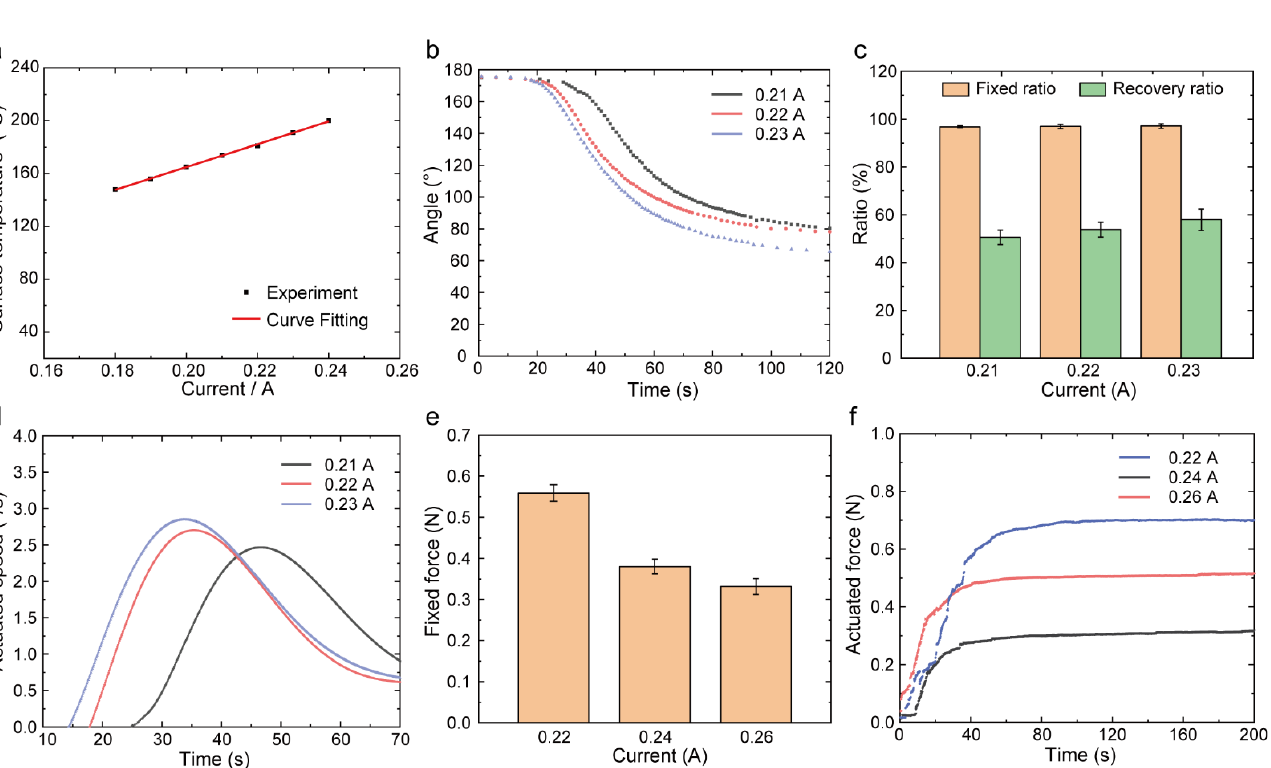
Figure 3. The effect of currents on shape memory properties and actuation performances. ( a ) The relationship between the surface temperature of samples and currents of wire. ( b ) The variation in angle for different currents in the recovery process. ( c ) The angular speed for different currents. ( d ) The shape memory properties for different currents. ( e ) The fixed force for different currents. ( f ) The recovery force for different currents.